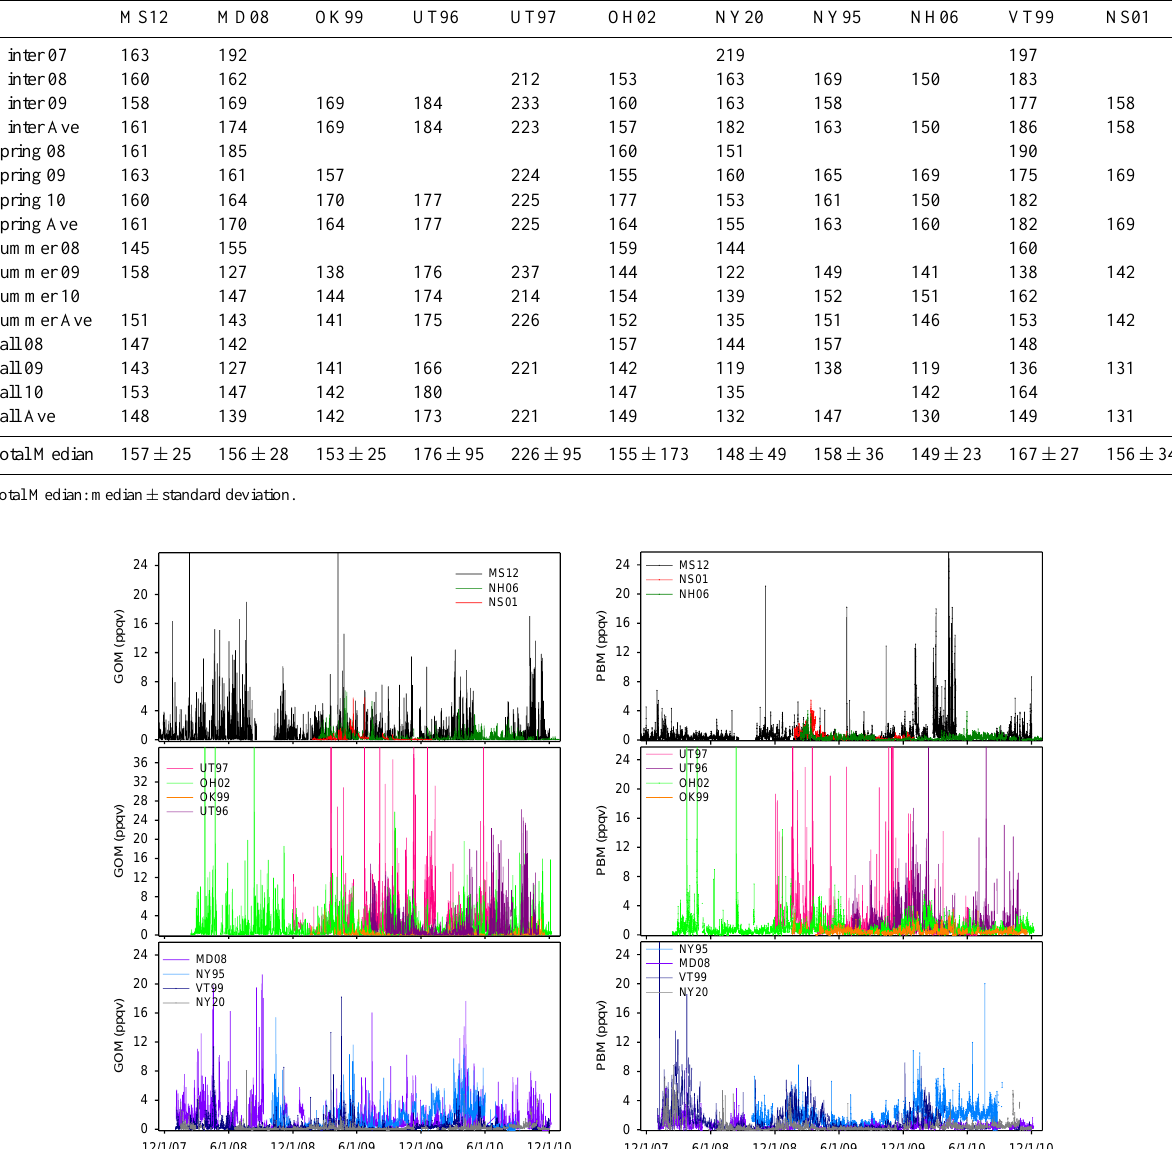
Table 2. The seasonal and total medians of GEM at 11 AMNet sites.